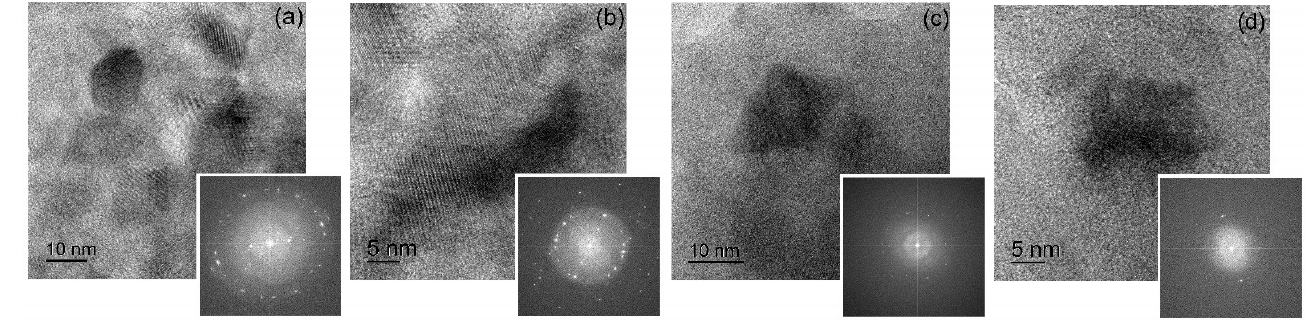
Figure 7. High-resolution TEM images with corresponding FFT images for ( a , b ) sample A and ( c , d ) sample B.